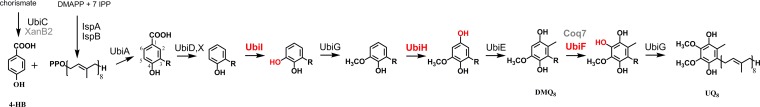
Biosynthetic pathway of ubiquinone 8 (UQ8) in E. coli. The numbering of the aromatic carbon atoms used throughout this study is shown for the product of the prenylation reaction catalyzed by UbiA. The octaprenyl tail is represented by R on carbon 3 of the different biosynthetic intermediates. Enzymes catalyzing the hydroxylation reactions are shown in red (UbiI, UbiH, and UbiF), and those replacing Ubi proteins in some proteobacteria are in grey (XanB2 and Coq7). DMAPP, dimethylallyl pyrophosphate; IPP, isopentenyl pyrophosphate; 4-HB, 4-hydroxybenzoic acid; DMQ8, C-6-demethoxy-ubiquinone 8; UQ8, ubiquinone 8.